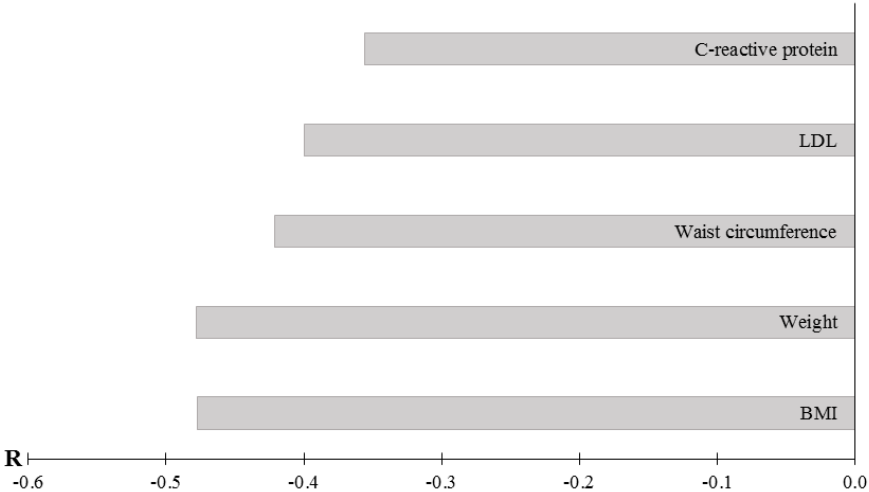
Figure 9. Correlation coefficients between Bacteroides fragilis content and anthropometric and biochemical parameters. Notes: total data for all patients, the results of the study are presented using p < 0.05. A search for correlations between the studied parameters was performed using Spearman’s test.